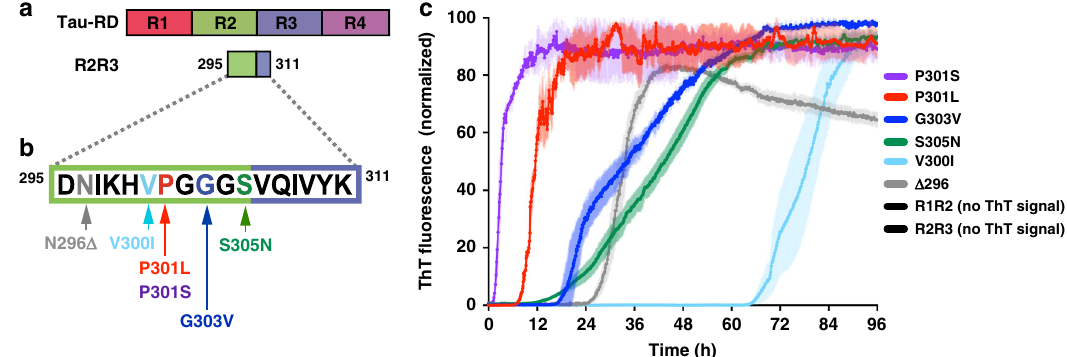
Fig. 4 Tauopathy mutations drive aggregation propensity. a Schematic of tau RD and the derived peptides representing the minimal structural element around 306 VQIVYK 311 . b WT and mutant peptides were disaggregated, resuspended to 200 µ M, and allowed to aggregate in the presence of ThT at room temperature. The WT R2R3 and R1R2 fragment peptides yielded no detectible ThT signal change (less than twofold ratio to background signal) over the course of the experiment (see Supplementary Data 1). ThT signals are shown as average of triplicates with standard deviation, are colored according to mutation and are normalized to the maximum for